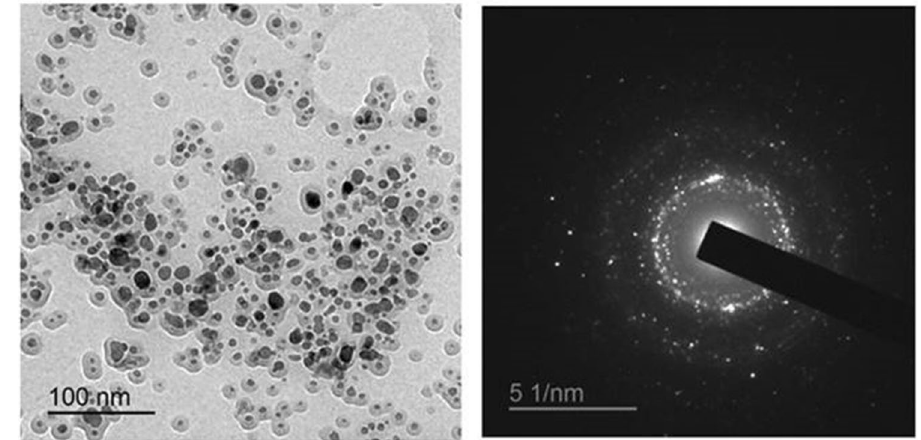
Figure 1. Examination of Magnetic GA nanocomposites by HR-TEM.